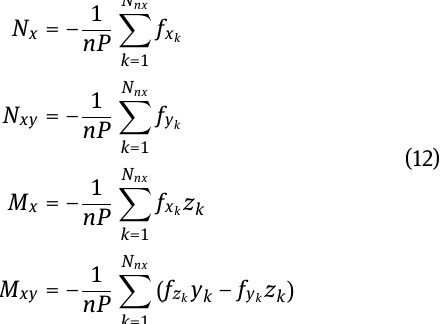
the distance to the lami- 3